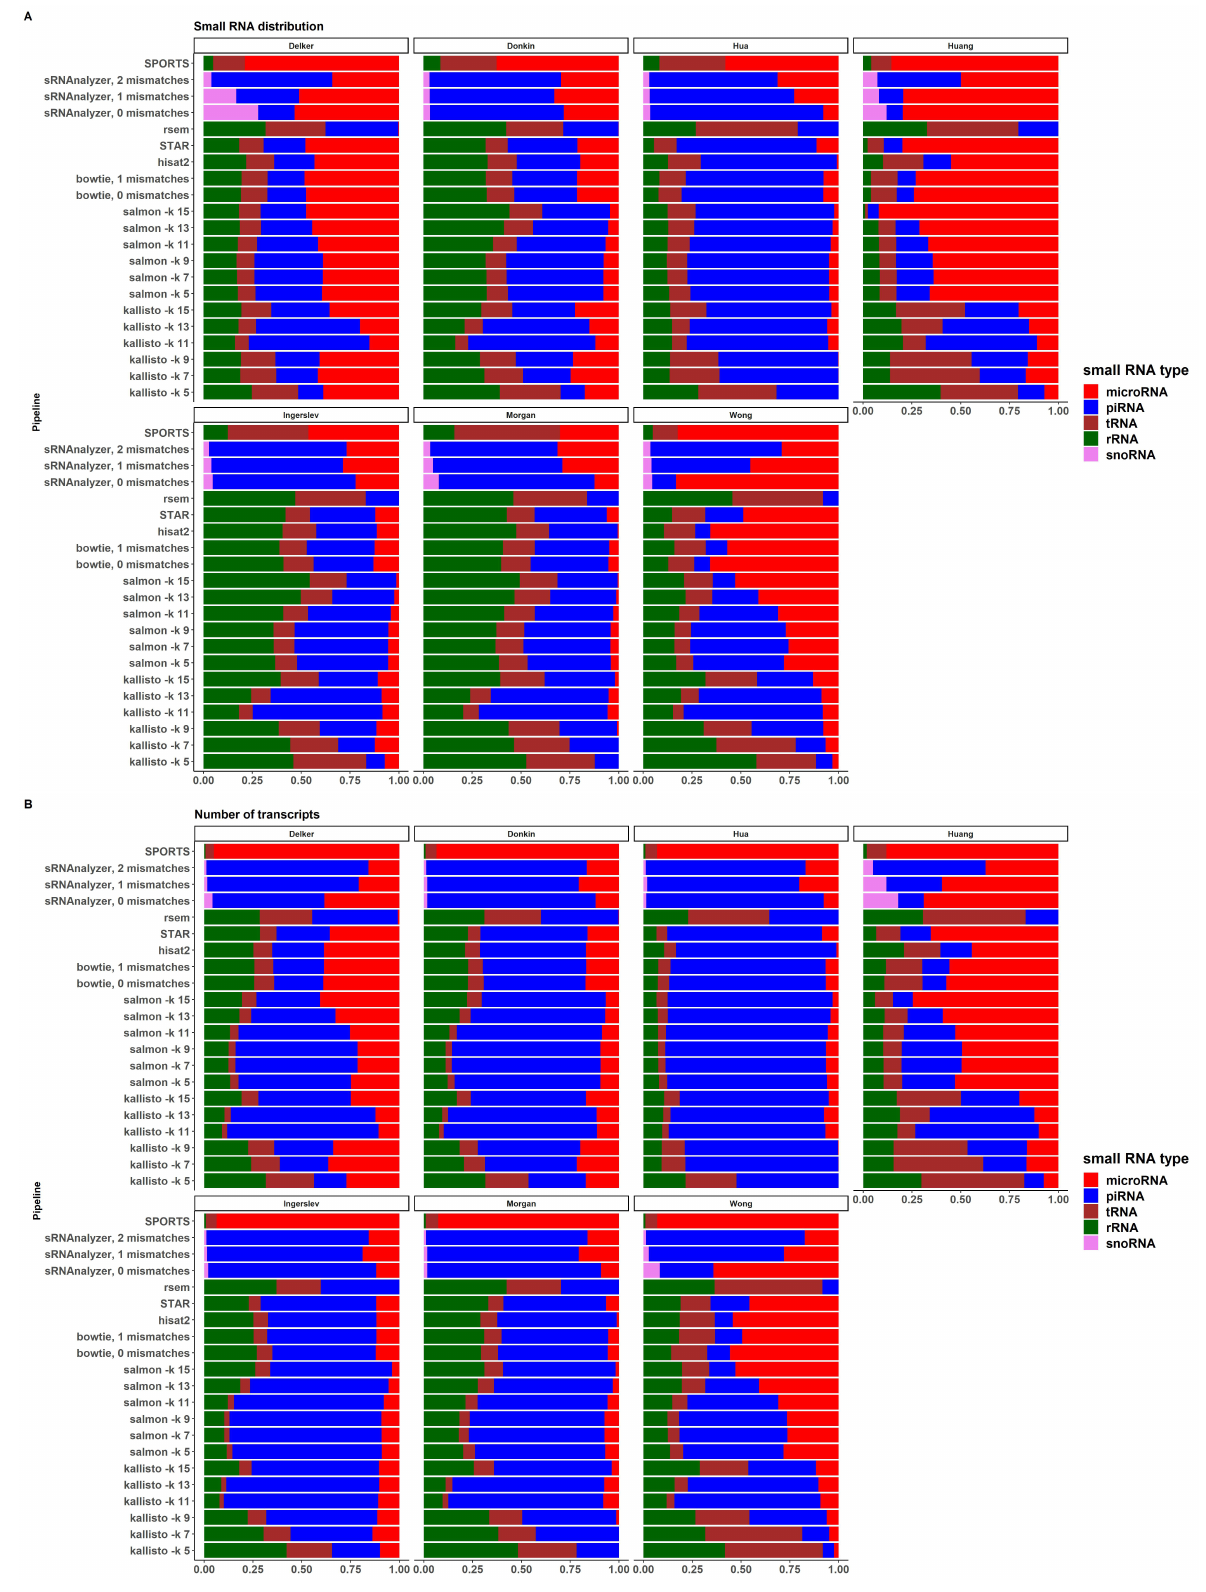
Figure 5. ( A ) Distribution of sRNA types’ expression values by datasets [58–64] and pipelines ( B ) Distribution of sRNA types’ transcripts by datasets [58–64] and